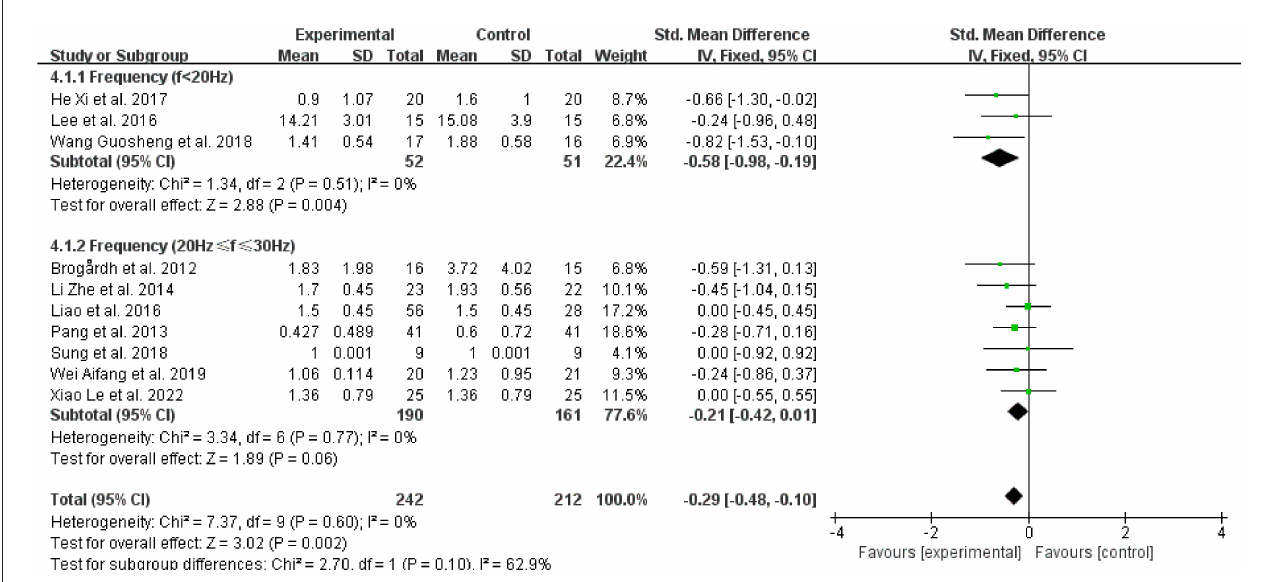
FIGURE9 Forest plot analysis of the efficacy of WBV in subgroups divided on the basis of vibration frequency.